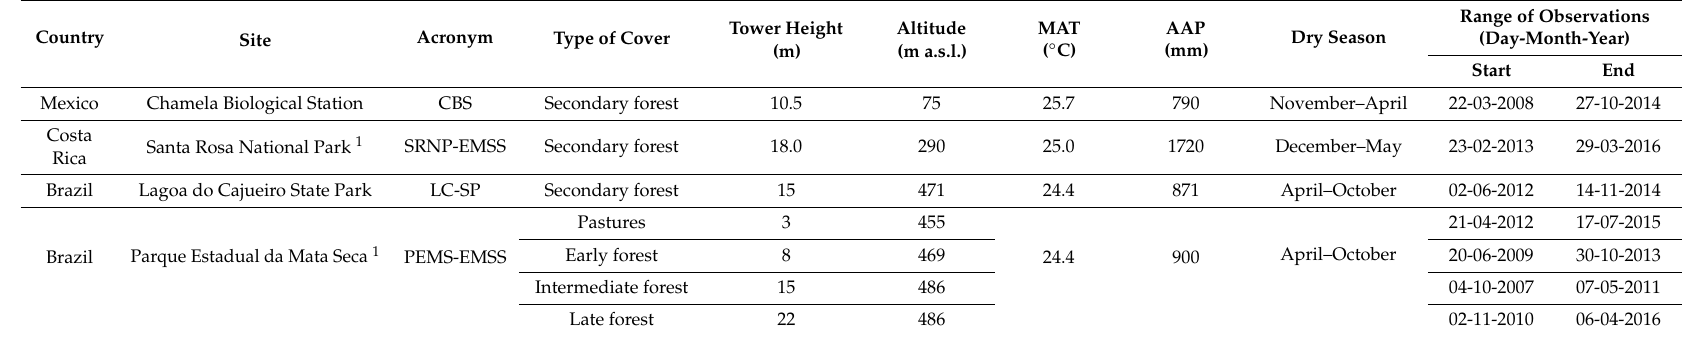
Table 1. Main characteristic of the sites where the optical phenological towers are located at four tropical dry forests along the Americas. Mean annual temperature (MAT), average annual precipitation